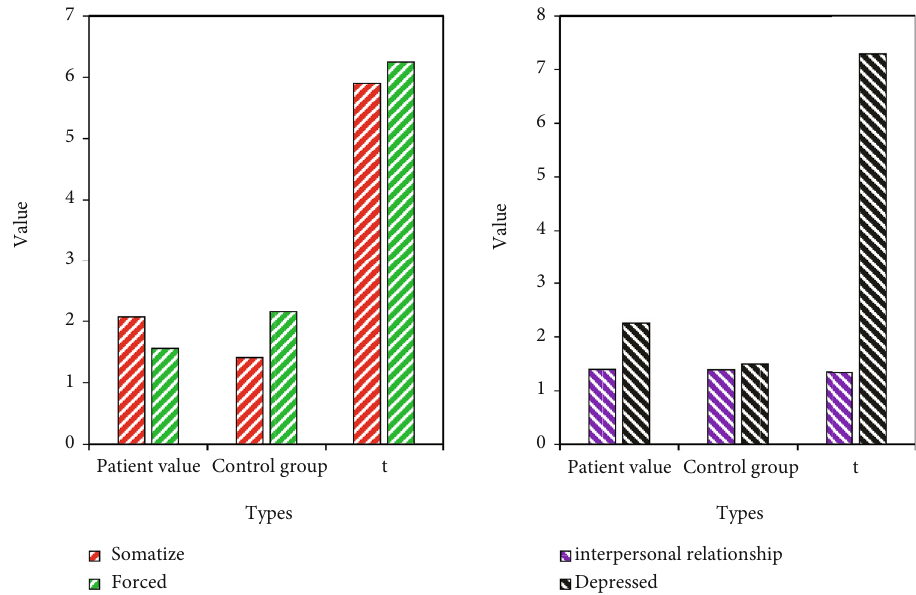
Figure 6: Comparison of SCL scores between patients with chronic prostatitis and healthy controls